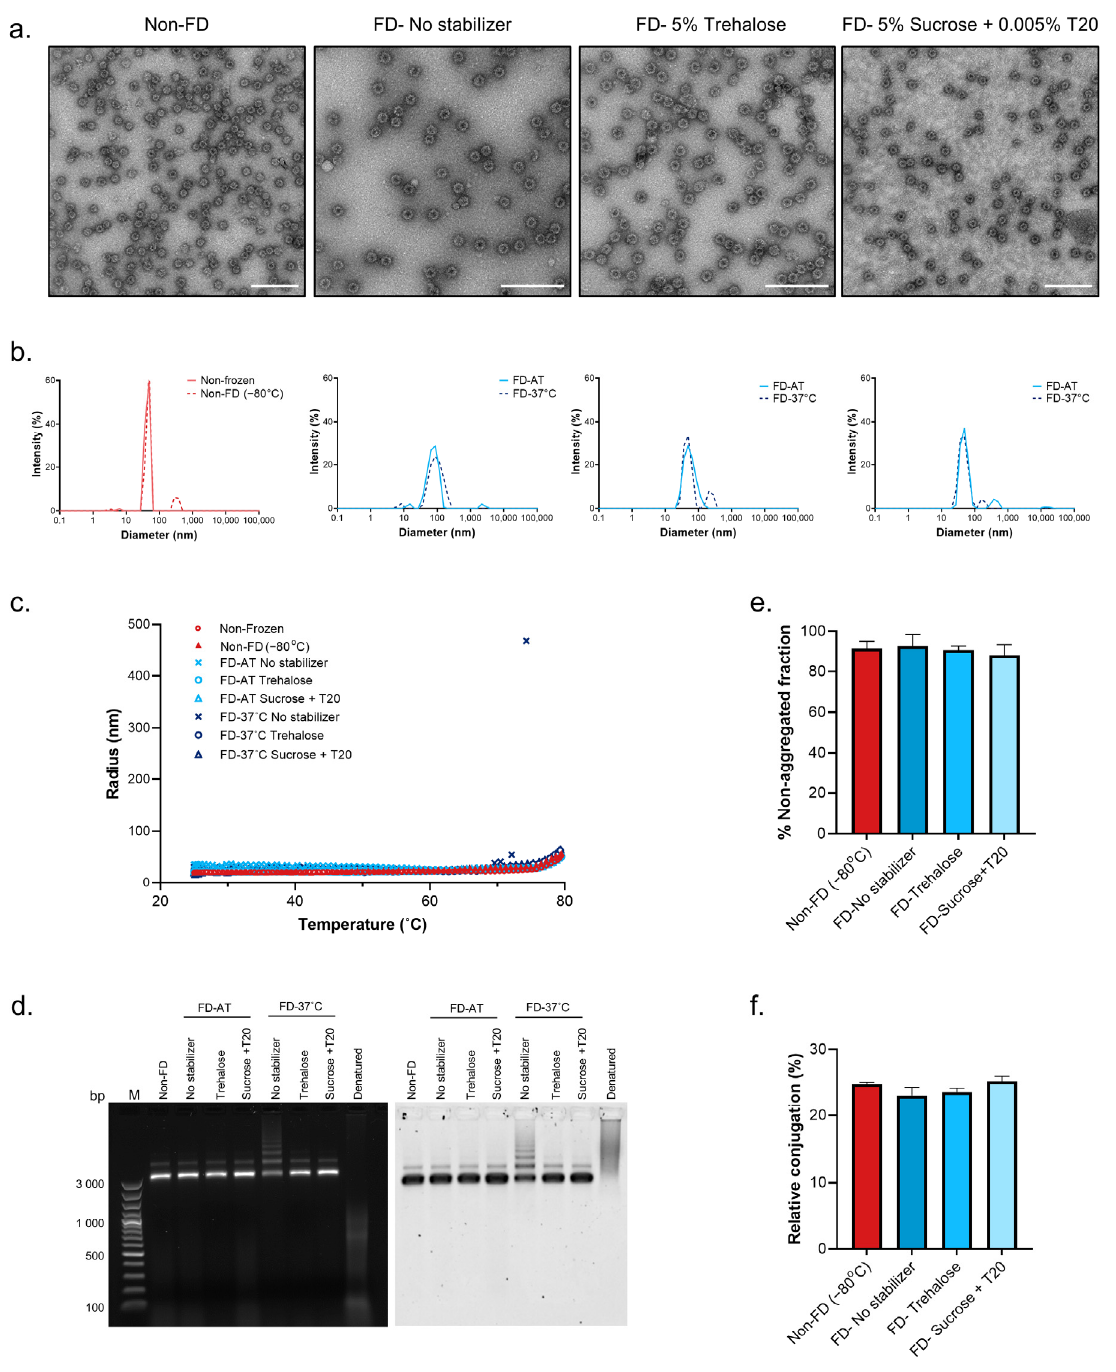
Figure 1. Stability of freeze-dried and reconstituted Catcher-cVLPs. Catcher-cVLPs formulated in pure sodium phosphate buffer (pH 7.4) or with the addition of stabilizing excipients (5% trehalose or 5% sucrose + 0.005% Tween ® 20 (T20)) were freeze-dried and subsequently stored at ambient temperature (FD-AT) or 37 ◦ C (FD-37 ◦ C) for 1 week ( A ) or 2 months ( B – F ). The stability of reconstituted freeze-dried material was compared to a non-frozen or a frozen non-freeze-dried (non-FD ( − 80 ◦ C)) reference sample. ( A ) Negative stain transmission electron microscopy (TEM) images. Scale bar represents 200 nm. ( B ) Dynamic light scattering (DLS) analysis of